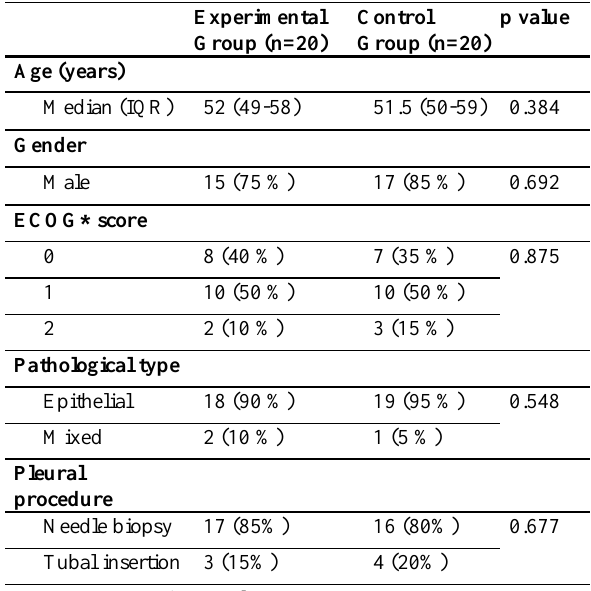
Table 1. Characteristics of patients